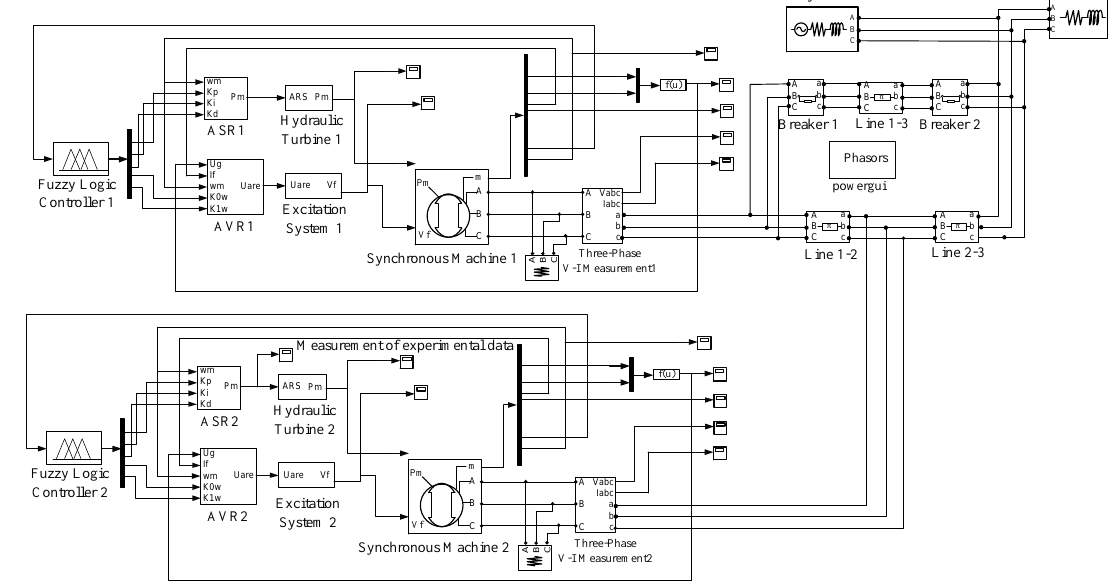
Figure 9. The model diagram of the network under study in MATLAB. Table 1. Parameters used in the model of the DG plant synchronous generator.